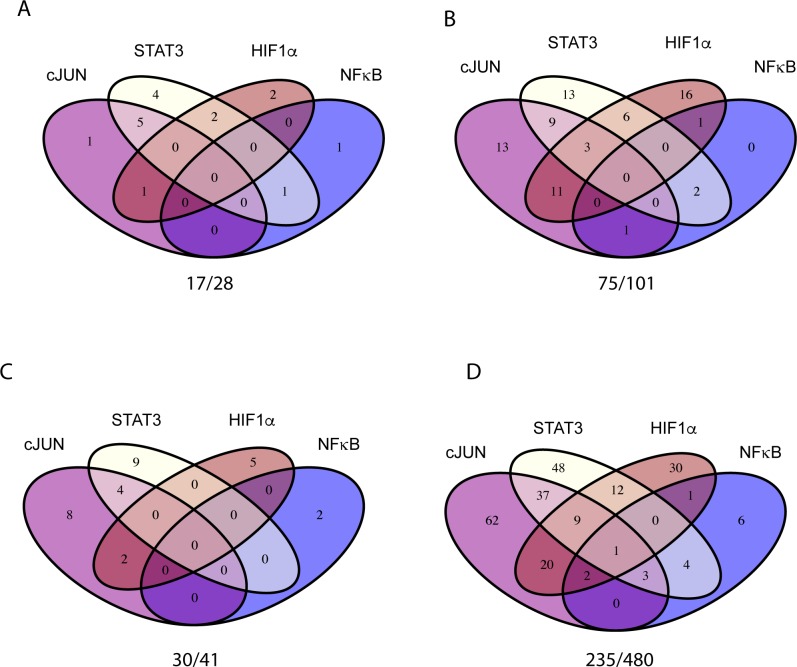
HIF1α is not the primary early transcription factor regulating gene expression in hypoxic or OGD–treated pericytes.ChIP-seq data for c-JUN, NFκB, STAT3 or HIF1α were analysed for binding peaks near (5Kbp) the transcriptional binding site of genes regulated (fc>1.5, p<0.05) in hypoxic or OGD treated pericytes. Venn diagrams are for (A) 2h hypoxia, (B) 6h hypoxia, (C) 2h OGD or (D) 6h OGD-treated pericytes. The numbers of genes regulated by either of the four transcription factors (x) compared to the total number of regulated genes (y) are presented as (x/y) below each graph.